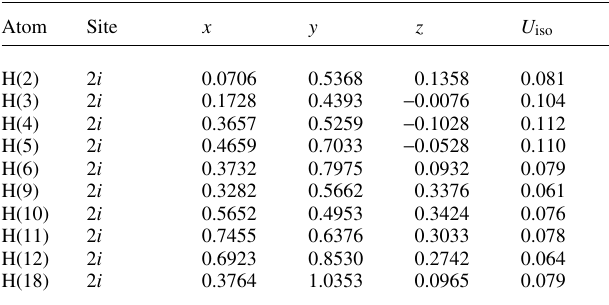
Table 2. Atomic coordinates and displacement parameters (in Å 2 )